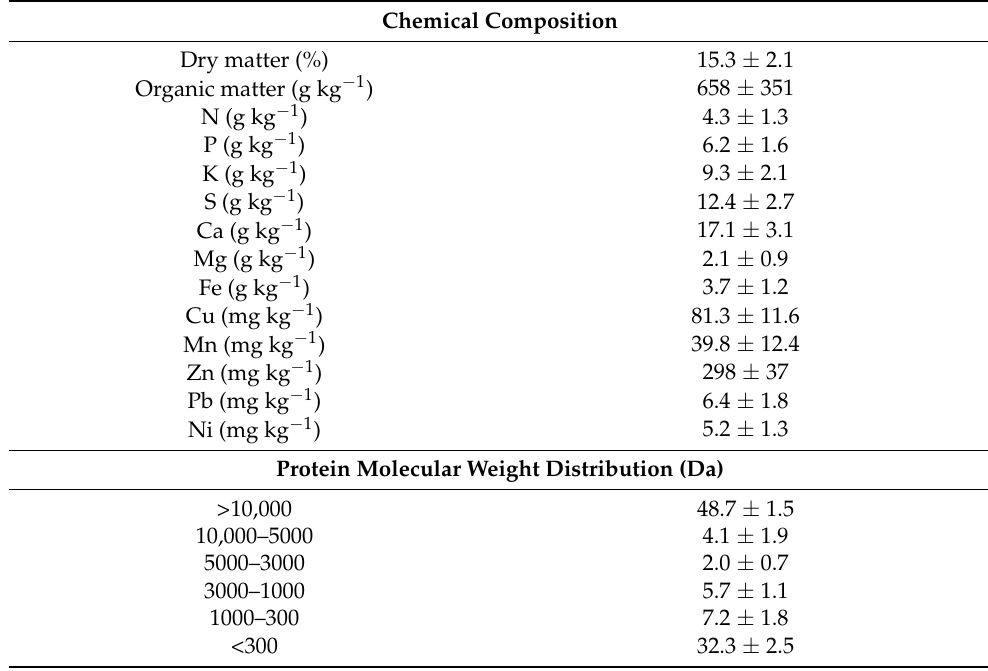
Table 1. Chemical characteristics and protein molecular weight distribution of biostimulant obtained from slaughterhouse sludge by enzymatic hydrolysis